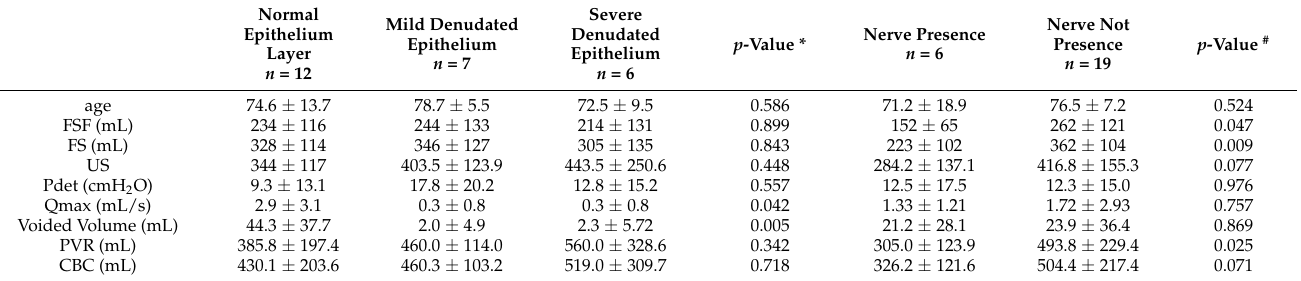
Table 3. Clinical parameters in patients with DU with bladder EM defects of varying severities. Normal